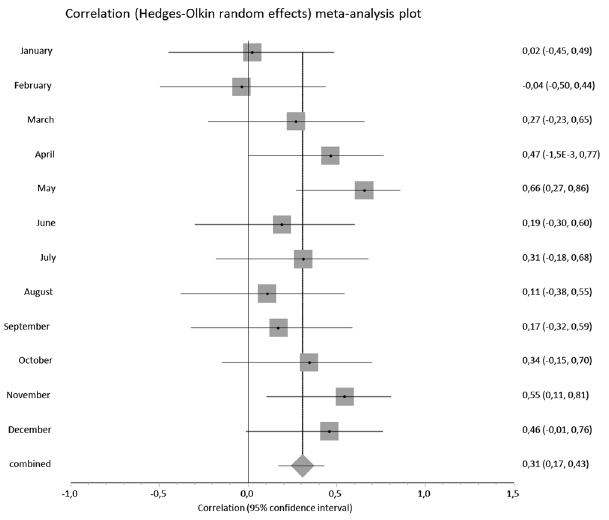
Figure 3. The correlation between violent crime rate and monthly mean ambient temperature in Finland, stratified by calendar month. During the 18-year follow-up, the pooled correlation co-efficient was 0.31 (N = 18, z-score 4.27, p = 2.0 × 10 − 5 ).